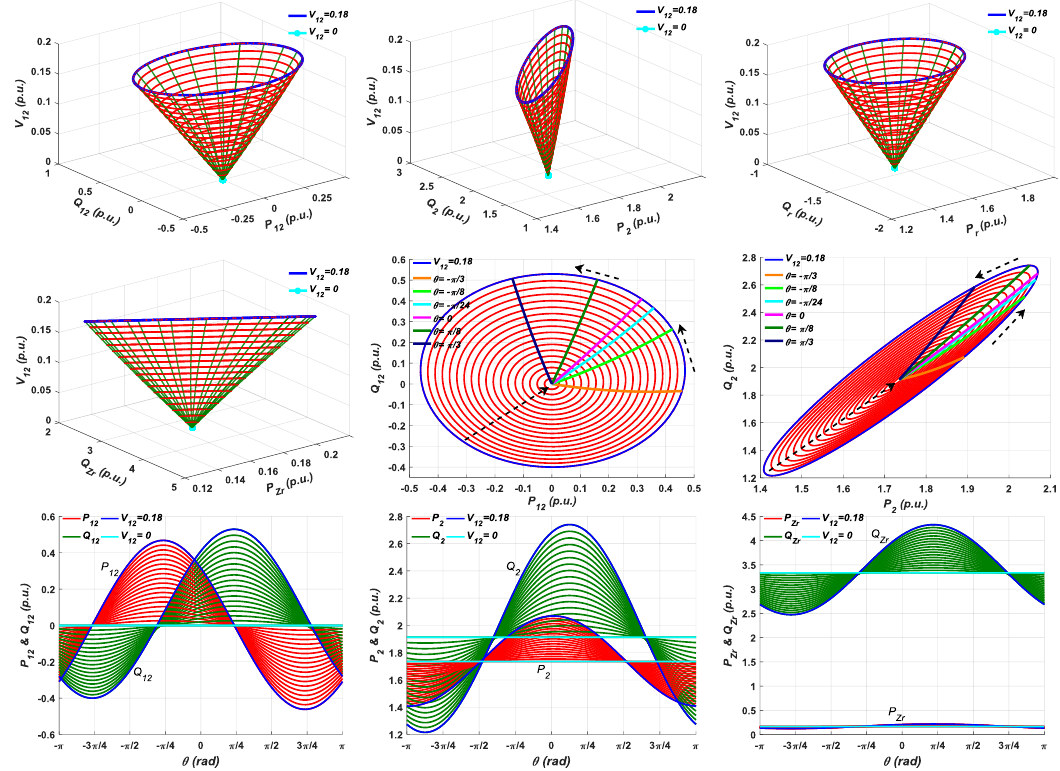
Figure 8. The power flow spatial operation surfaces and planes when V r = 0.82 , δ = – π/ 2.